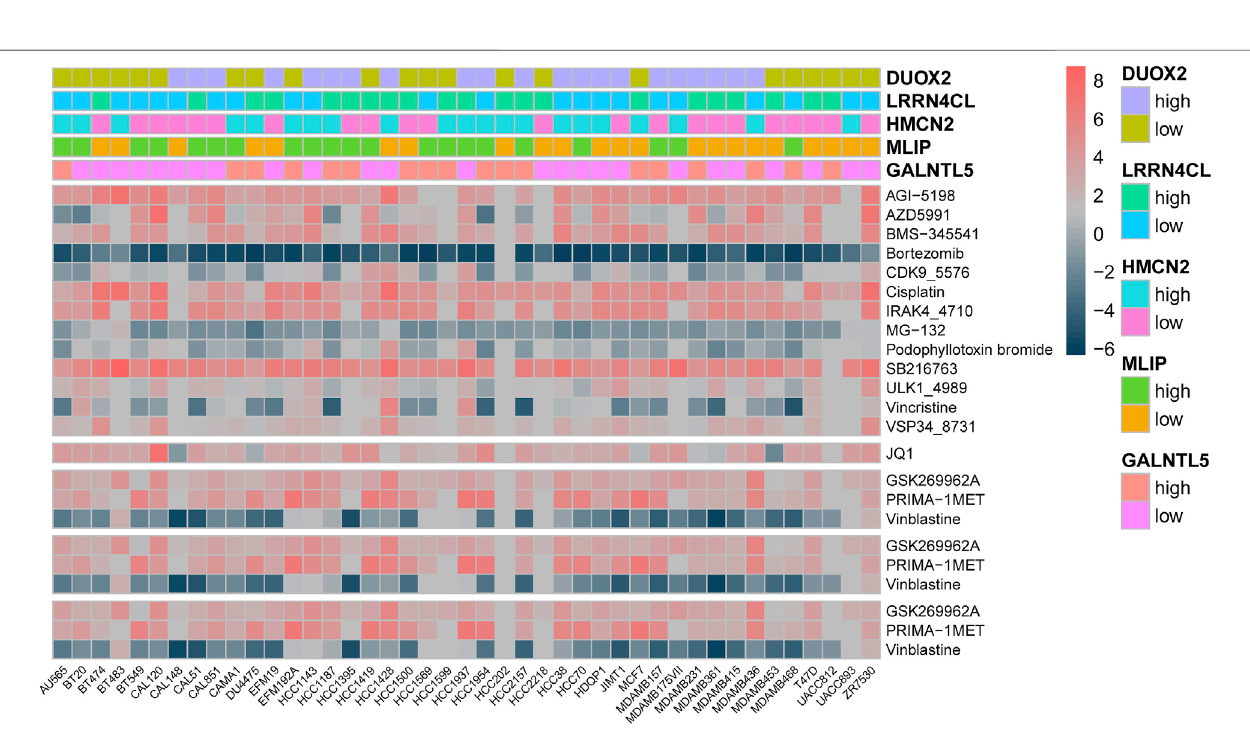
Frontiers in Genetics |